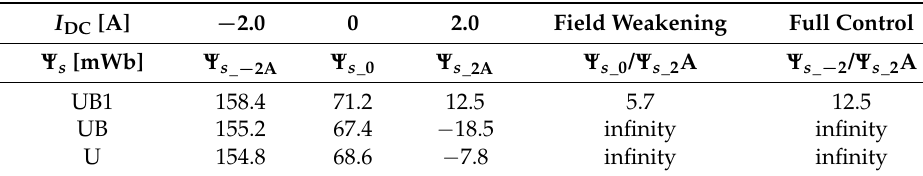
Table 1. 3D-FEA results of phase magnetic flux linkage.